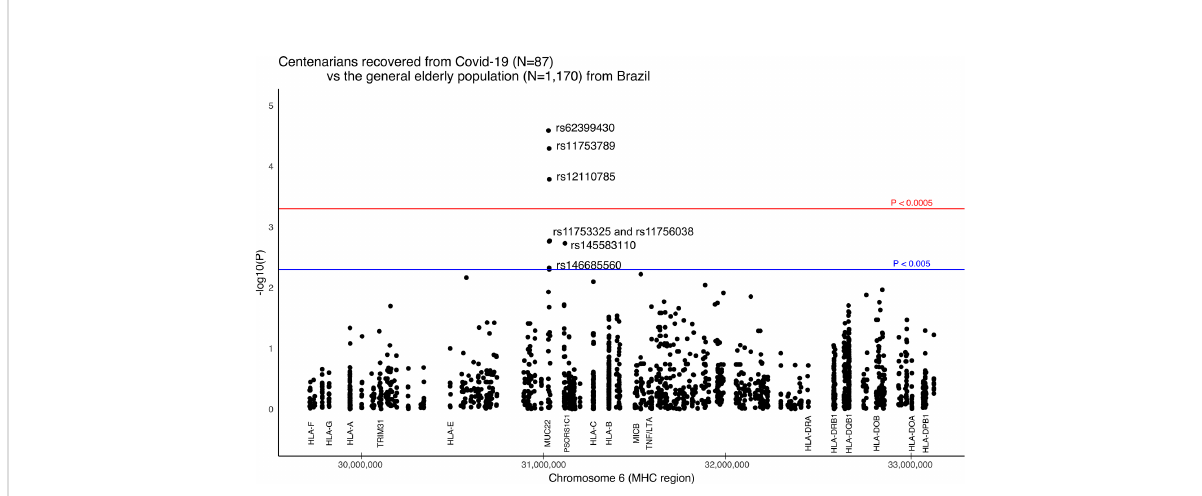
FIGURE 3 Manhattan plot illustrating differences between Brazilian centenarians (>90 y) recovered from Covid-19 and the general elderly population. The general population consists of whole-genomes (WGS) of 1,170 elders from São Paulo city (> 65 y), with unknown status regarding Covid-19. The centenarian group includes exomes of 87 patients more than 90 years old that presented mild Covid-19 symptoms. We considered only variants with a minor allele frequency of 1% in at least one of the groups, with no more than 5% of missing alleles in both groups, and with a ratio between read depth for each allele in heterozygous sites ranging from 0.3 to 0.5 for Exomes. The red line marks the threshold for detecting a variant associated with the phenotype by calculating the number of segregation blocks observed in our data. The blue line marks the suggestive threshold for a candidate variant, p < 0.005. Most MUC22 variants are in Linkage Disequilibrium (r 2 >